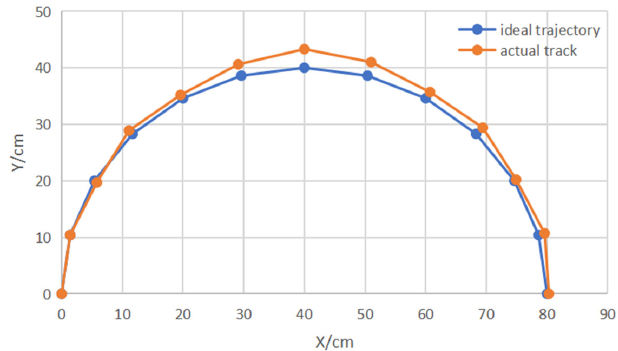
Figure 20. The turning trajectories of the chassis in the laboratory.